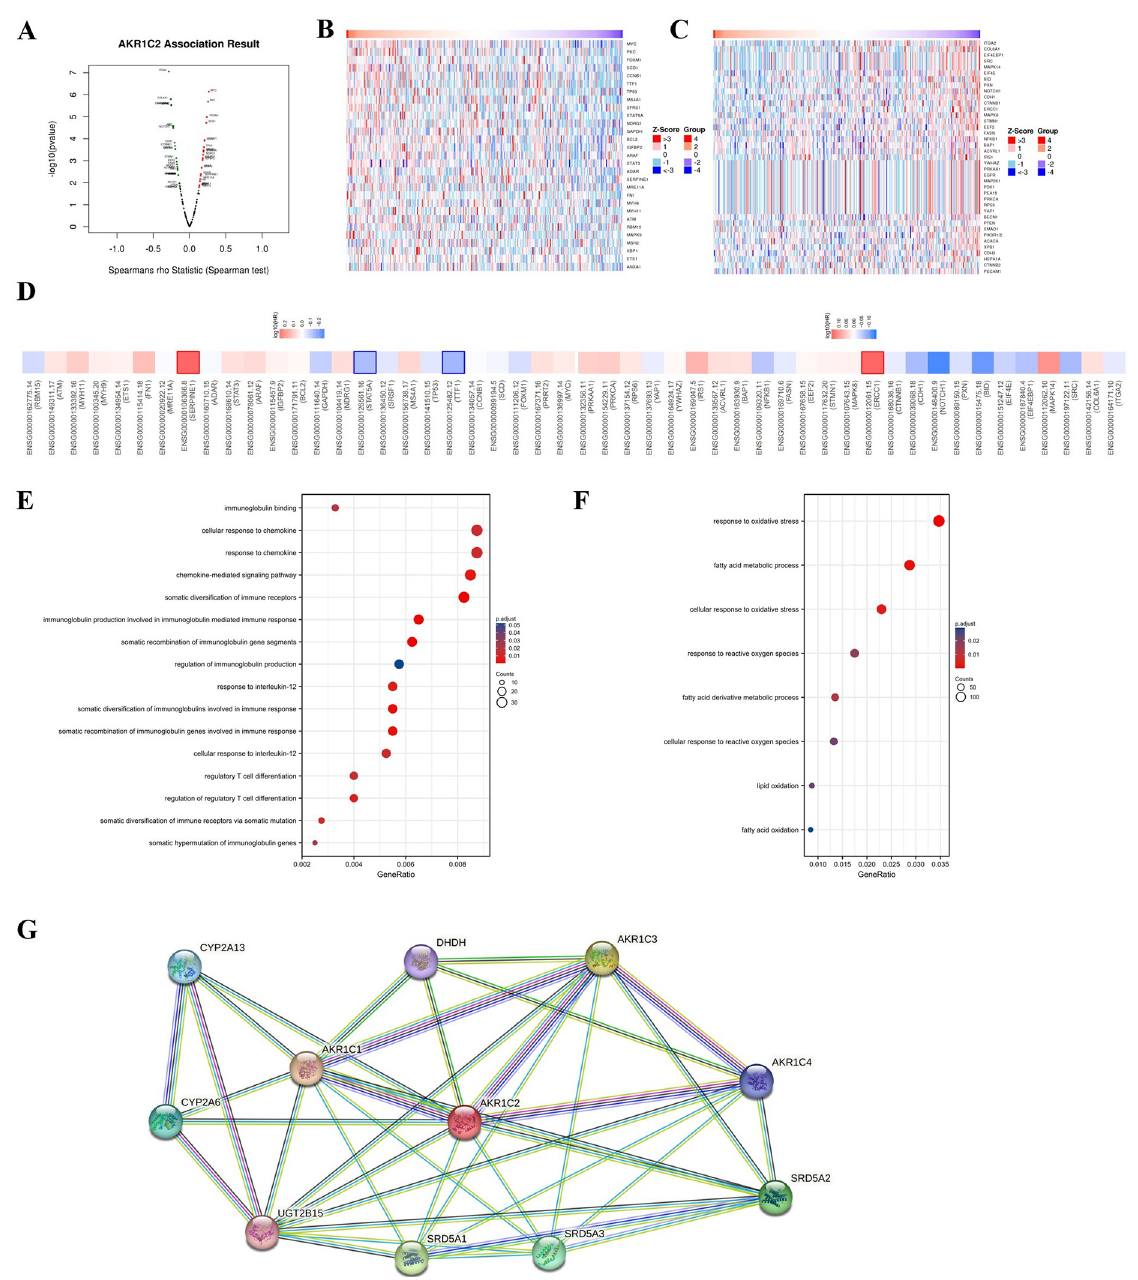
Fig 4. The co-expressed genes of AKR1C2 in GC. (A) The LinkedOmics portraying the AKR1C2-related genes in GC. (B) The heatmap indicated the top 29 genes that possessing positive correlation with AKR1C2 in GC. (C) The heatmap indicated the top 39 genes that possessing negative correlation with AKR1C2 in GC. (D) Survival heatmaps illustrating the top 50 genes possessing positive and negative relationship with AKR1C2 in GC. (E-F) GO enrichment analysis of AKR1C2 co-expressed molecules in GC patients. (G) The protein- protein network of AKR1C2 via STRING